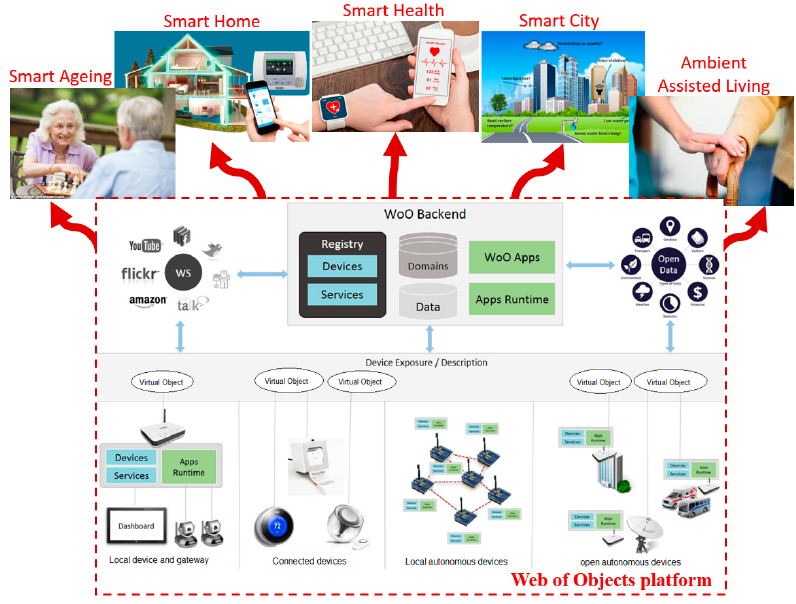
Figure 1. Example application domains in the Web of Objects platform [1].